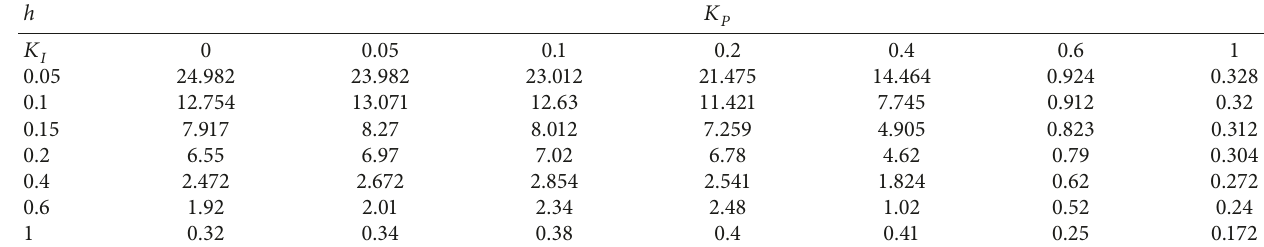
,K ) (two-area LFC with μ � 0 , ρ � 0 , τ � 0). P I , K ) for two-area LFC with μ � 0 . 9 , ϱ � 0 . 025 , τ � 0 . 025. P I